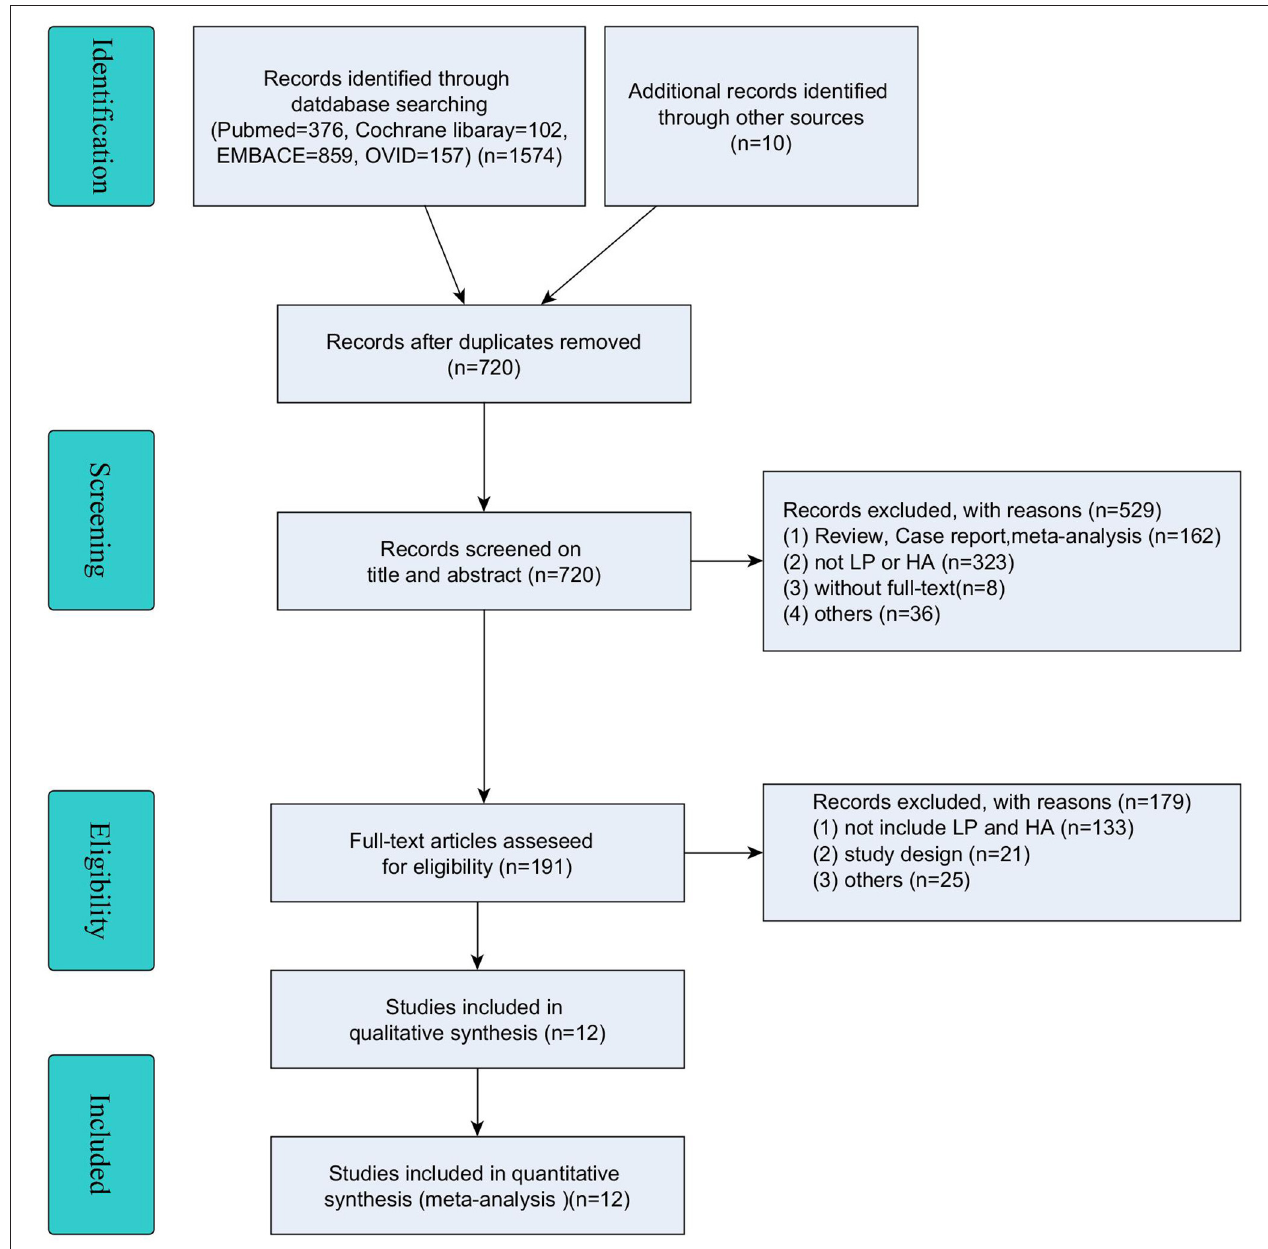
FIGURE 1 | Flowchart of study